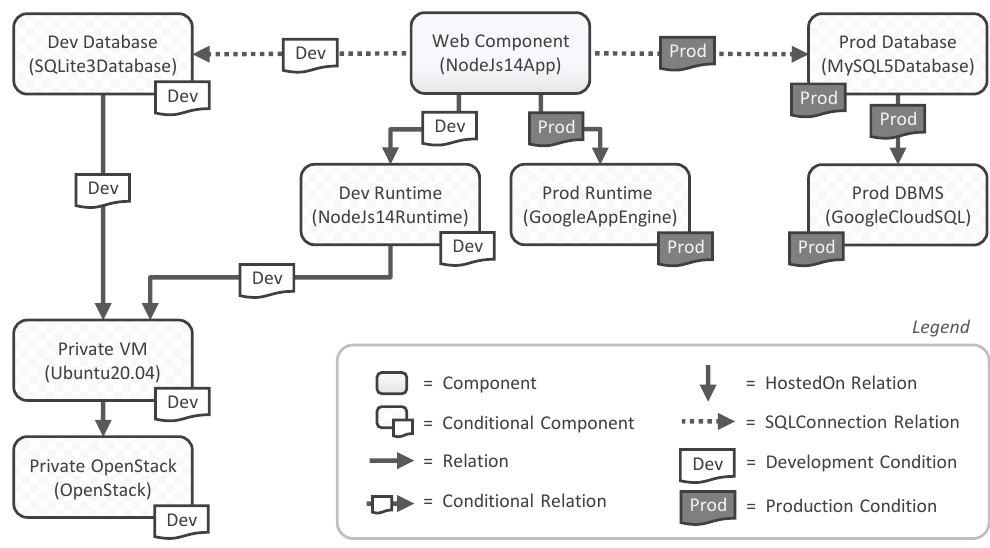
Figure 3. Variable Deployment Model of our motivating scenario.